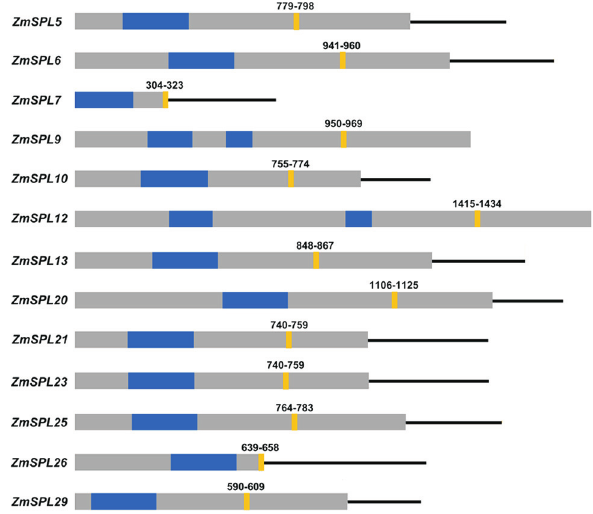
Figure 5 - ZmSPLs targeted by miR156. Open reading frames (ORFs) are indicated by grey rectangles, the SBP domain is shown by blue rectangles, and the lines flanking ORFs represent 3’ UTRs. miR156 targeting sites are indicated by yellow rectangles.